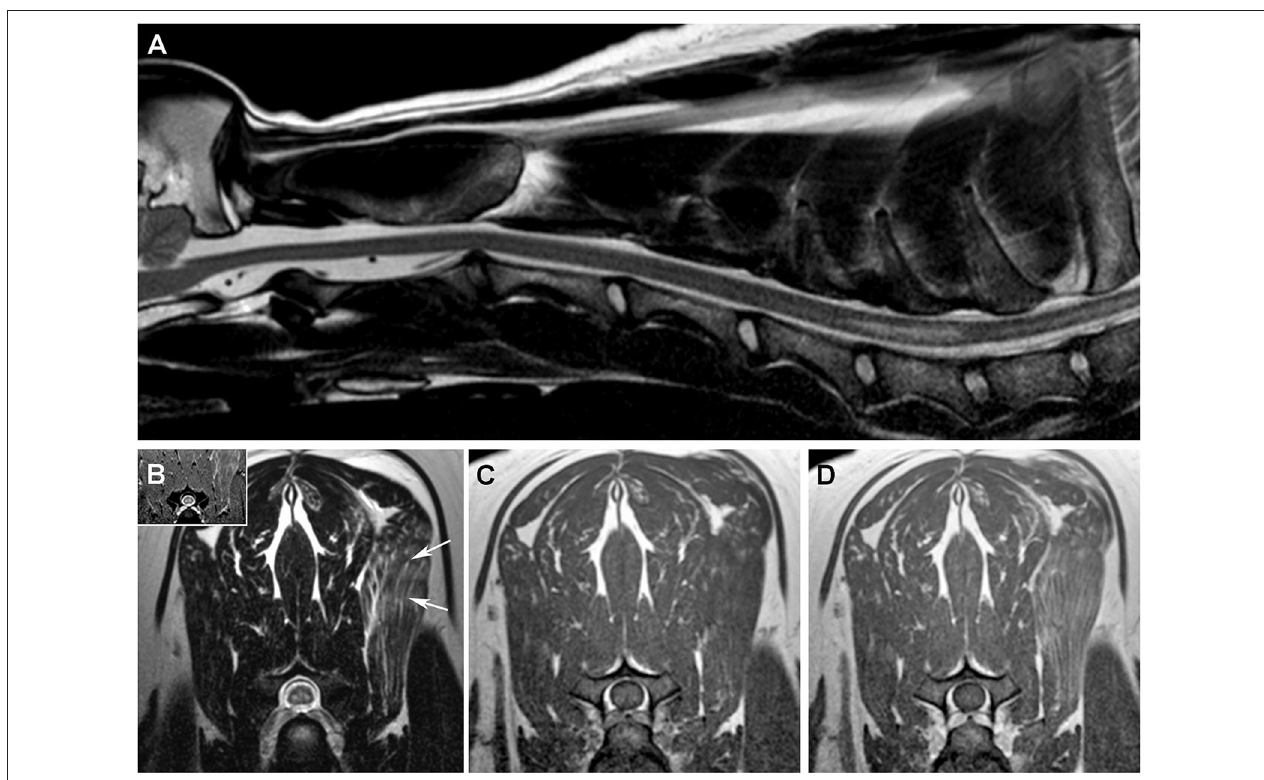
FIGURE 4 | MRI features of the SEM-like phenotype, Case 4. (A) Sagittal T2W image with linear hyperintense intramedullary lesion extending from the cranial aspect of C6 to the cranial aspect of C7. On transverse images, SEM appears as bilaterally symmetric T2W and T2*GRE (B) hyperintense lesions in the ventral gray matter that are T1W isointense (C) and non-enhancing following intravenous gadolinium administration (D) . There is heterogeneously increased T2W signal [ (B) , arrow] and contrast enhancement (D) of the left serratus ventralis